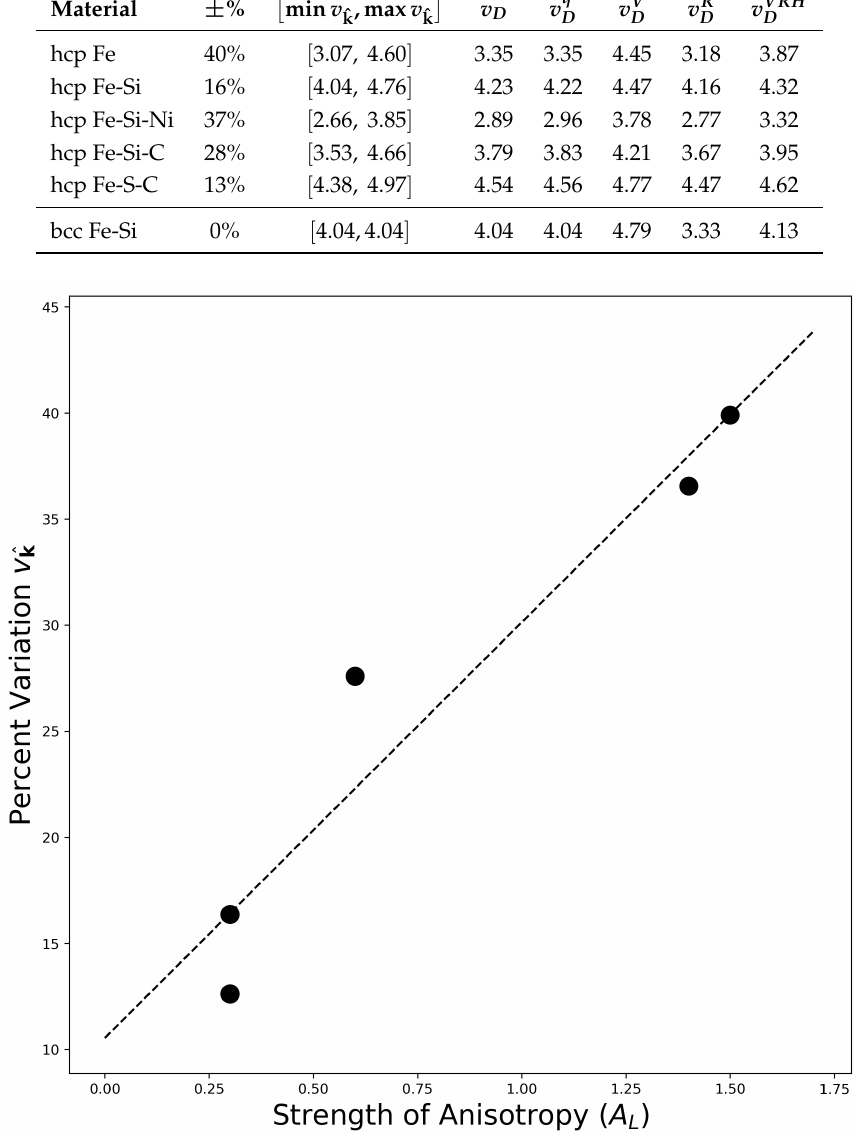
Figure 2. Percent variation of v ˆ as a function of the strength of anisotropy A L for the five hcp iron k alloys (black circles) in Table 1. The dashed line represents a linear best fit to the